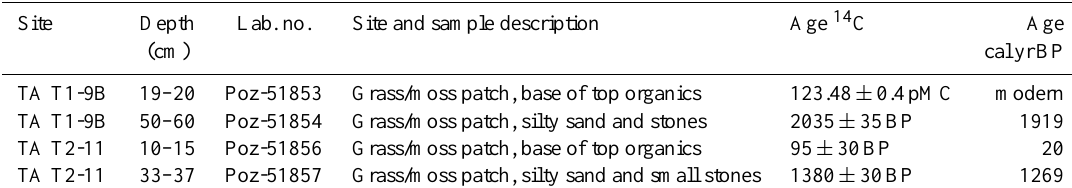
Table 3. Results from the radiocarbon analysis.